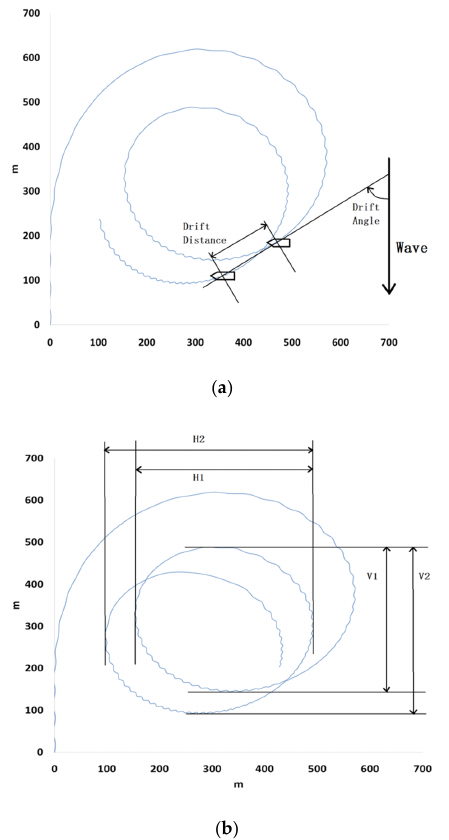
Figure 10. Parameters of the turning trajectory in waves: ( a ) Drift angle and drift distance; ( b ) Horizontal and vertical diameter of the turning trajectory.